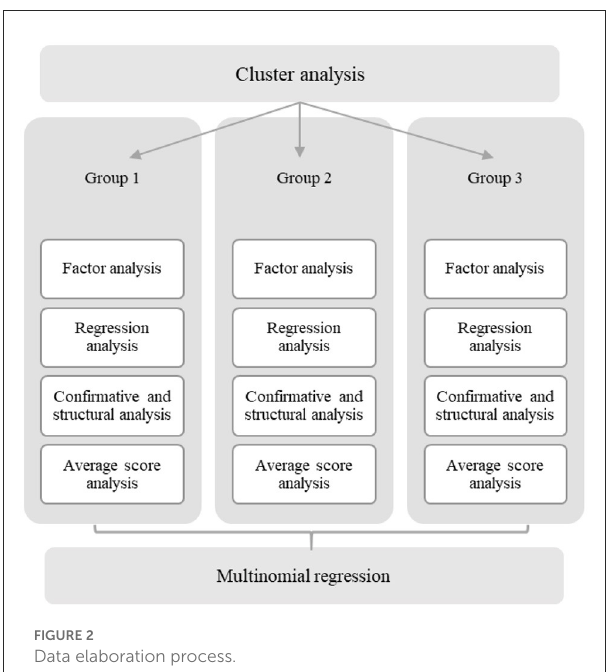
FIGURE2 Data elaboration